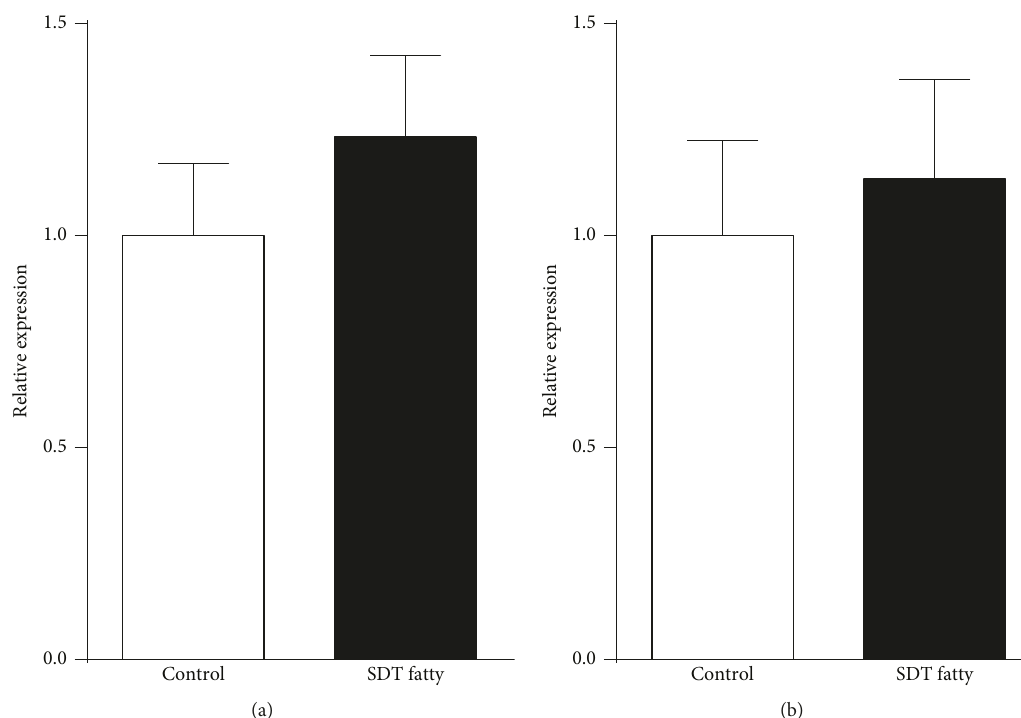
Figure 4: Relative expression of (a) arylalkylamine N-acetyltransferase ( Aanat ) and (b) acetylserotonin O-methyltransferase ( Asmt ) mRNA in the pineal gland of control Sprague – Dawley (SD) and Spontaneously Diabetic Torii (SDT) fatty rats at night (0400 hours). Data are mean +SEM ( n = 6 in each group). There were no signi fi cant di ff erences in Aanat and Asmt expression between the two strains ( P > 0 05 , Student ’ s t